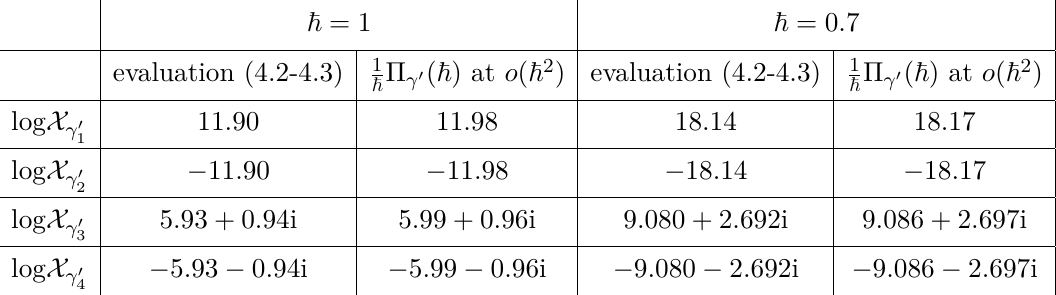
= 4 . 5 , u = 0 and Λ = 1 . 1 2